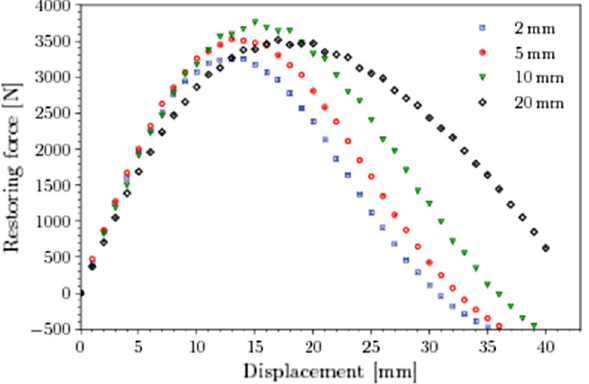
Fig. 4 Magnetic coupling vs displacement for arrangements with dif- ferent spacing distances between magnet pairs